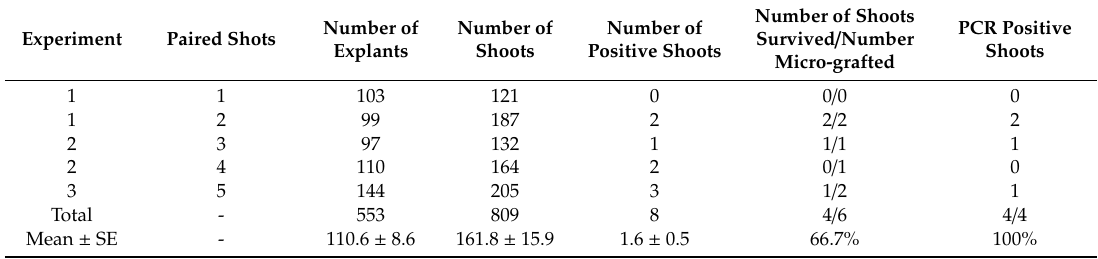
Table 2. Biolistic transformation of Citrus paradisi Macf. Duncan grapefruit x Poncirus trifoliata L. Raf (Swingle citrumelo) and the number of transgenic shoots produced, micro-grafted and tested with PCR. Number of Number of Experiment Paired Shots Explants